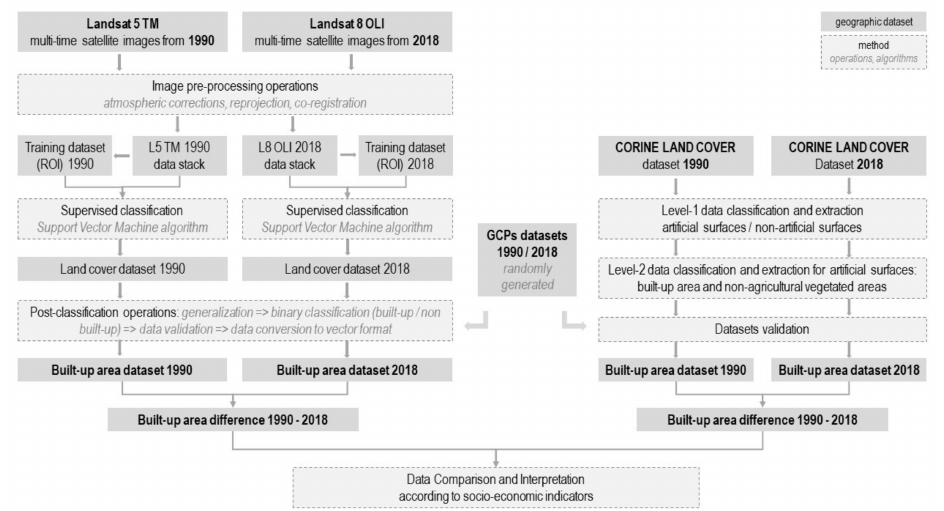
Figure 2. Scheme of the integrated Landsat image processing–CLC vector data analysis for built-up area diachronic mapping in Bucharest and Ilfov County, Romania